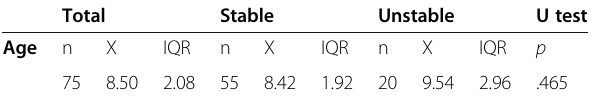
Table 2 Descriptive statistics for age at the beginning of treatment Total Stable